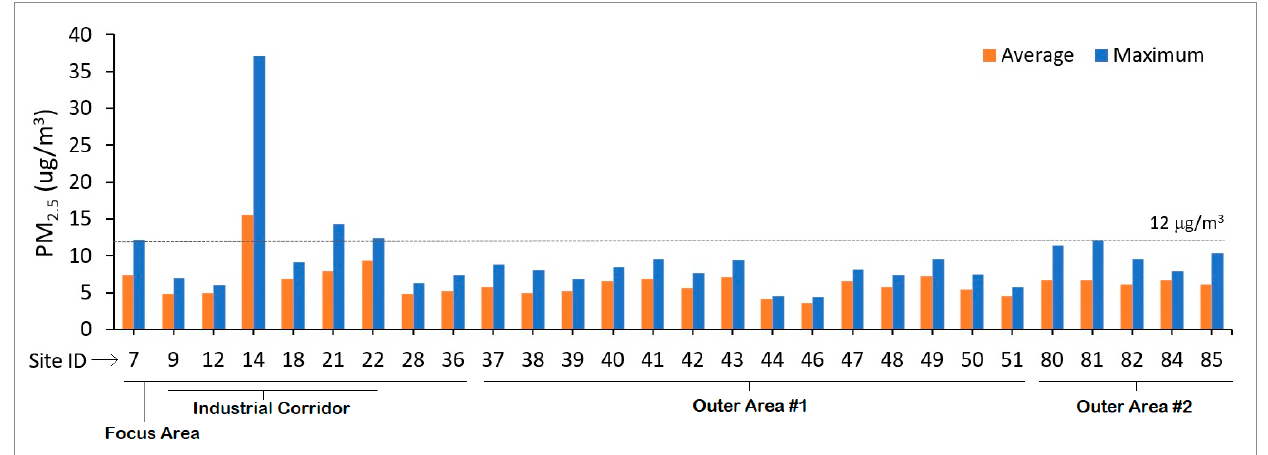
Figure 5. February sampling day, where average and maximum PM 2.5 concentrations were found to exceed 12 μ g/m 3 across four sites.